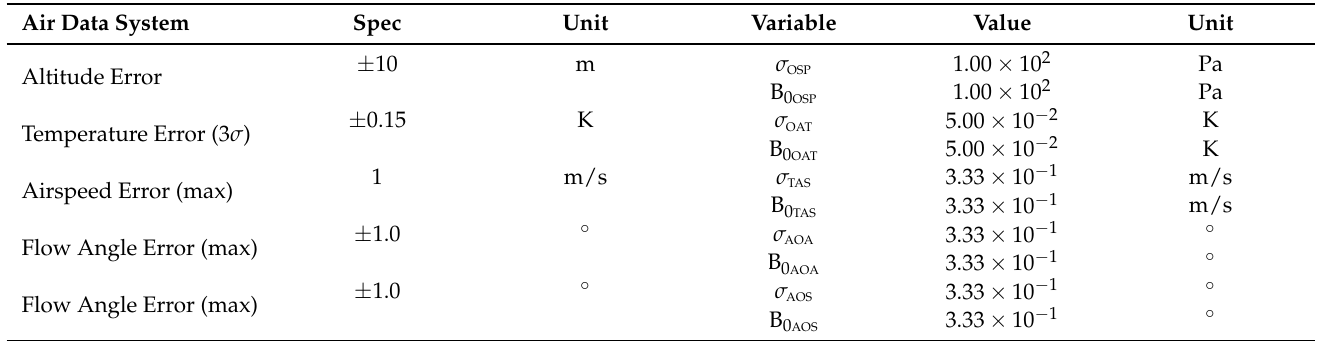
Table 19 suggests appropriate values for the IMU platform and camera pose